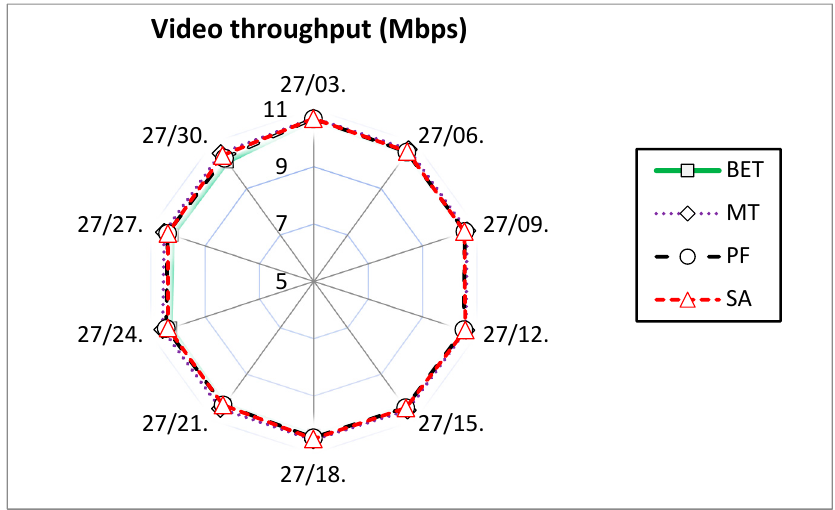
Figure 10. Uplink cell throughput for video users in mixed traffic.